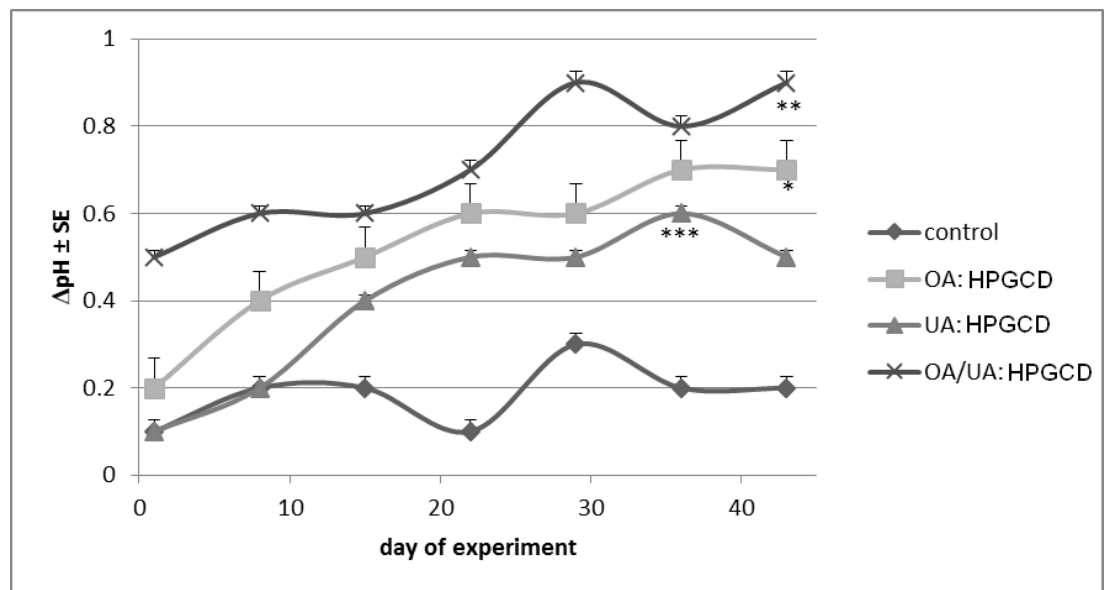
Figure 8. Skin-pH